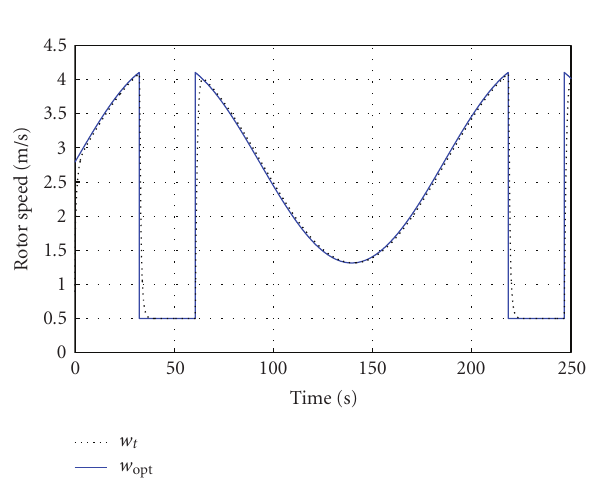
Figure 19: Rotor speed tracking.